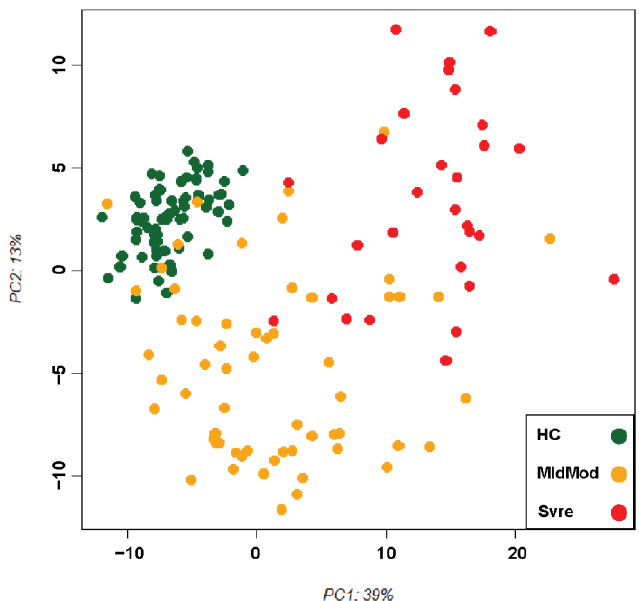
Figure 1. Principal component analysis (PCA) of all samples . PCA plot of PC1 and PC2 is based on rlog transformed (DESeq2) normalized expression values. It shows levels of healthy controls (HC), mild/moderate (MldMod), and severe (Svre) COVID-19 cases by different colours.